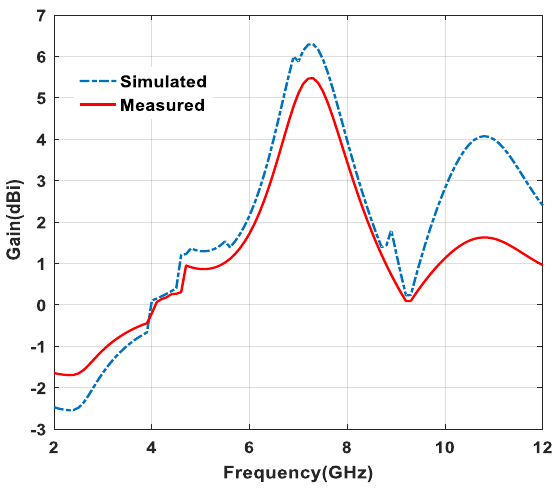
Figure 13. Gain versus frequency plot.